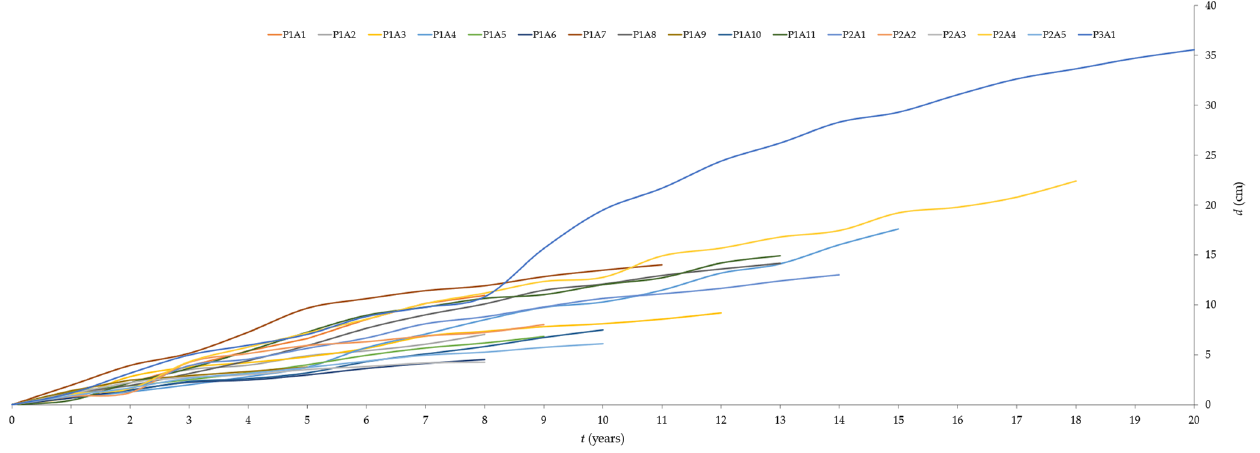
Figure 4. Relationship d = f( t ) for the trees used in the study.